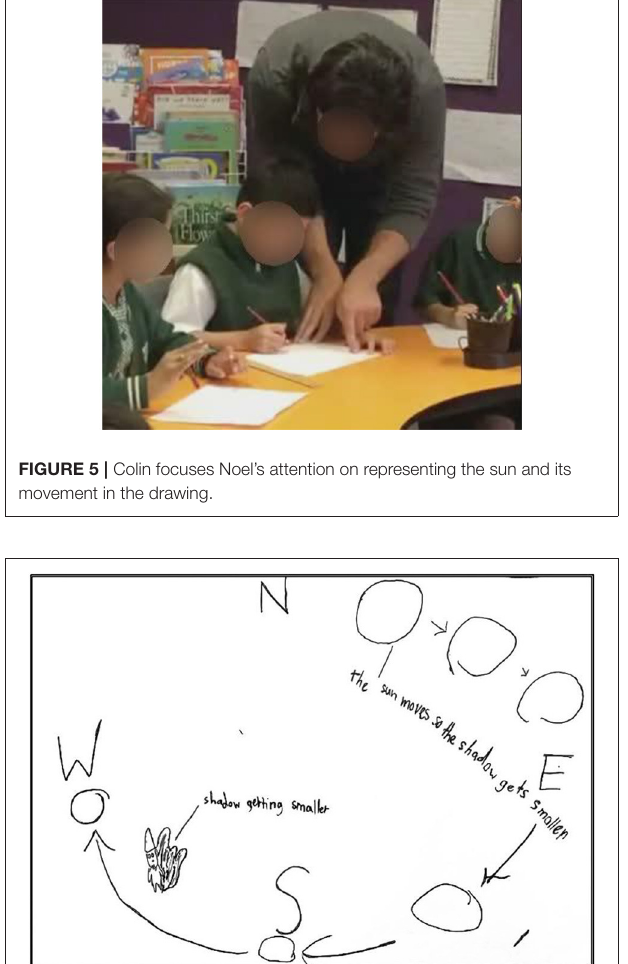
(sun) to explore its effect on shadow direction and